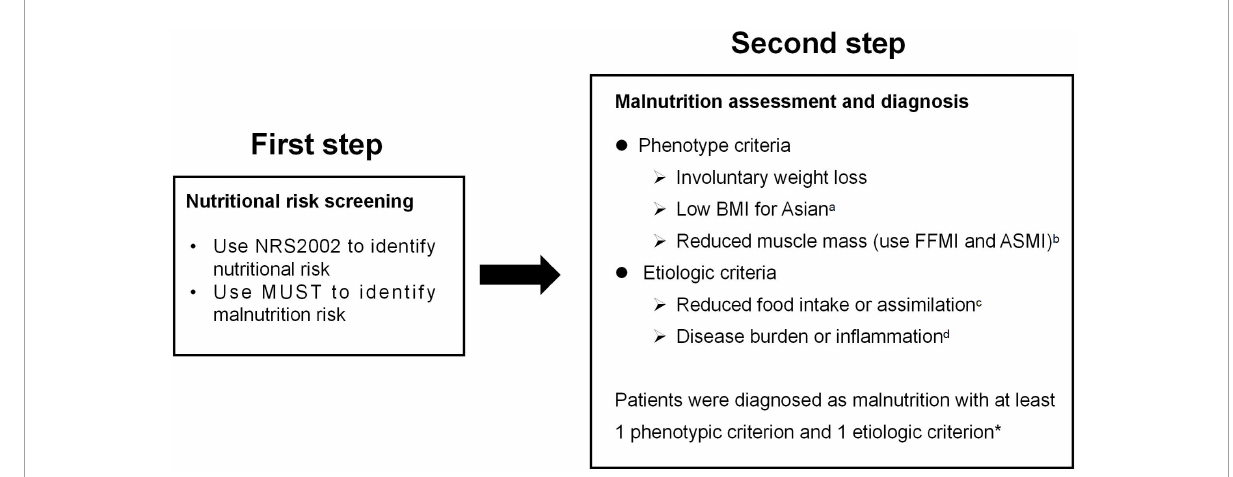
FIGURE1 GLIM diagnostic scheme for screening, assessment, and diagnosis of malnutrition in our study. a BMI < 18.5 kg/m 2 if < 70 years or < 20 kg/m 2 if > 70 years; b FFMI < 15 kg/m 2 for women, < 17kg/m 2 for men,or ASMI < 5.7 kg/m2 for women, < 7.0kg/m 2 for men; c < 50% of energy requirements > 1 week, or any reduction for at least 2 weeks, or any chronic gastrointestinal symptoms that lead to inadequate or impaired absorption and assimilation in patients; d inflammation associated with acute disease/injury or chronic disease; *In this study, patients diagnosed with Crohn’s disease were all thought to meet the etiologic criterion as GLIM consensus mentioned that most chronic organ diseases, such as Crohn’s disease, are associated with reduced food intake or impaired absorption and